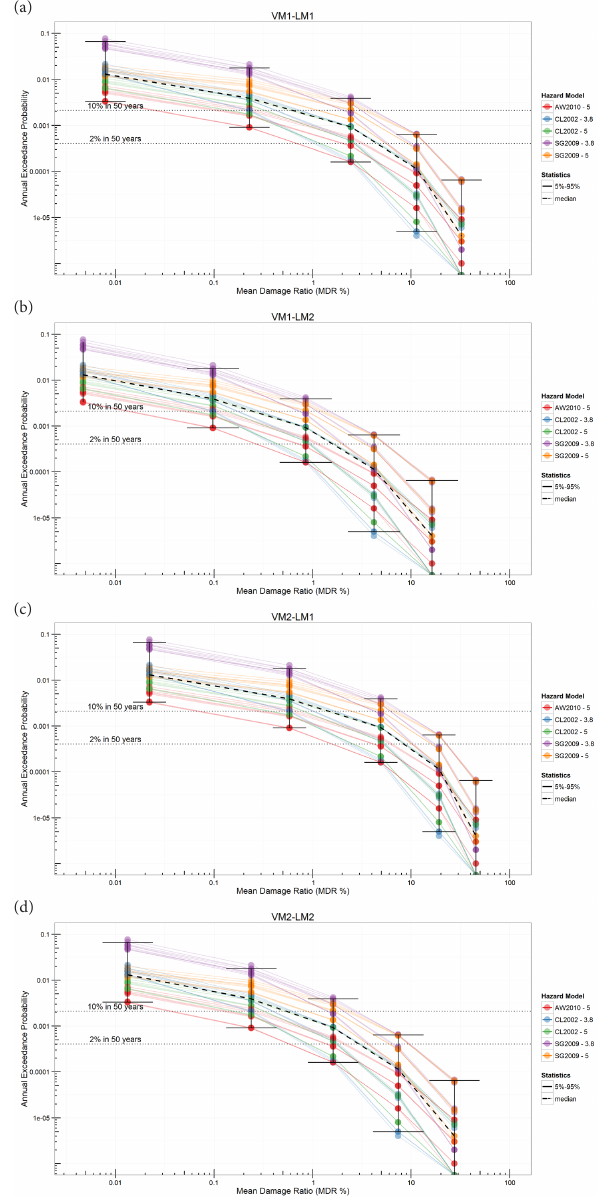
Figure 11. Comparison of the risk curves for different combinations of the vulnerability and loss models: (a) VM1 and LM1, (b) VM1 and LM2, (c) VM2 and LM1, (d) VM2 and LM2.